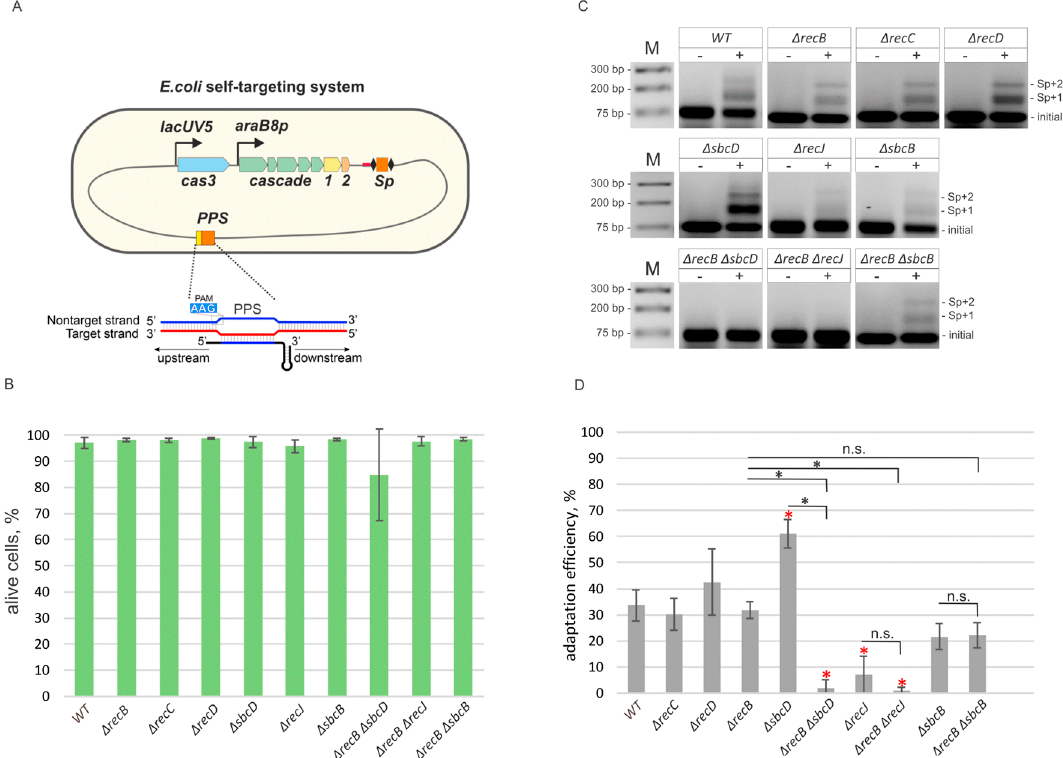
Figure 1. Components of genome maintenance pathways contribute to primed adaptation efficiency. ( A ) A self-targeting E. coli strain KD403 used to study the effects of non-CRISPR genes of primed adaptation is schematically shown. KD403 contains the cas3 gene under IPTG-inducible lacUV5 promoter and the cse1 , cse2 , cas5 , cas6 , cas7 , cas1 , cas2 operon under the control of arabinose-inducible promoter araB8p . A minimized CRISPR array contains a single spacer (Sp) corresponding to a priming protospacer (PPS) in the non-essential yihN gene. The leader region is shown in red. The structure of the R-loop complex on PPS is shown in the inset. ( B ) Cultures of KD403 self-targeting cells and derivatives with mutations in recB , recC , recD , sbcD , recJ , sbcB , recB sbcD , recB recJ , and recB sbcB genes were grown in the presence (“+”) or the absence (“ − “) of inducers and the number of live cells at 5 hours post induction was measured by live fluorescence microscopy. ( C ) Spacer acquisition determined by PCR amplification of the CRISPR array in uninduced (“ − “) and induced (“+“) cells 5 hours post-induction. Amplification products were resolved by agarose gel electrophoresis. Amplicons corresponding to initial, unexpanded CRISPR array and arrays expanded by one (“Sp+1”) and two (“Sp+2”) spacers-repeat units are indicated. A representative result of one of three independent experiments is shown. Data for two additional independent experiments (along with the one shown here) are presented in Figure S5. ( D ) Adaptation efficiency was measured as percentage of intensities of upper bands, corresponding to extended arrays, of the sum of intensities of upper and lower bands of agarose gels shown in panel C and normalized to values obtained for samples grown in the “absence” of inducers. The mean and standard deviations for three independent experiments are shown. Samples that significantly differ from wild-type KD403 strain are marked by red asterisks (pairwise t-test, p -value < 0.01) . The brackets above the bars indicate pairwise t-test comparisons between double mutants and corresponding single mutants (n.s., non-significant differences at p - value ≥ 0.01; black asterisks, significant differences at p -value < 0.01).